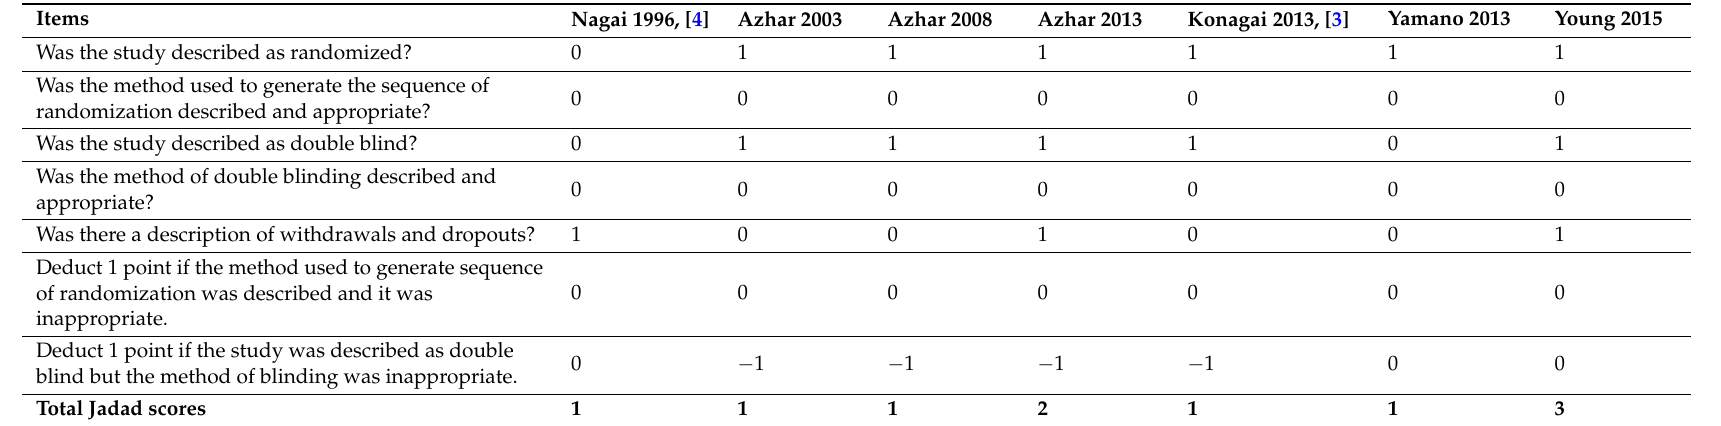
Table B1. Assessment of quality of trials using Jadad